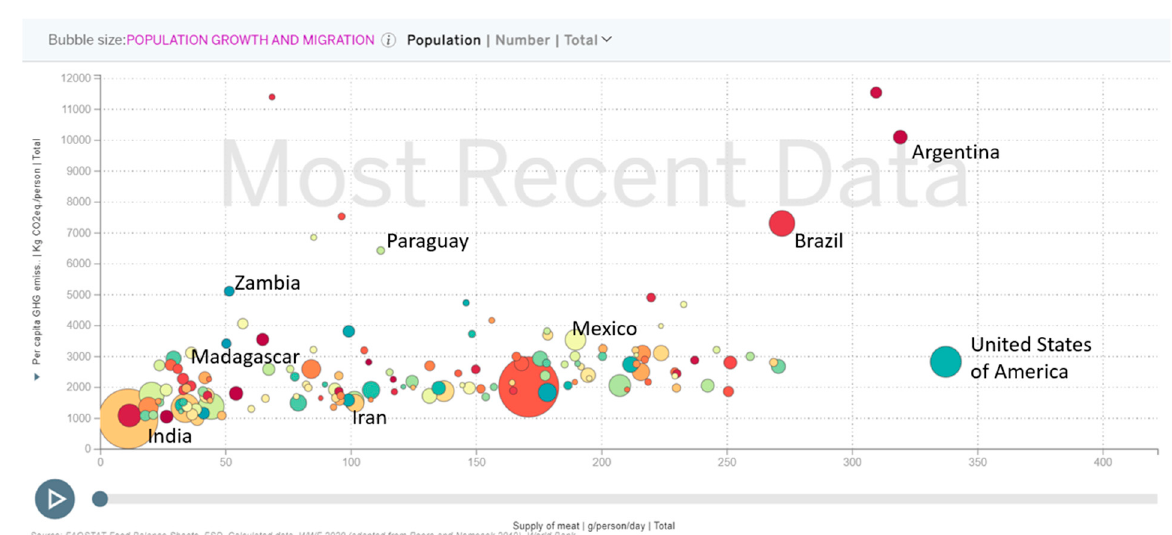
Figure 5. Per capita GHG emissions from food consumption versus the supply of meat, by country. Source: (“Food Systems Dashboard” 2020 [51,52])